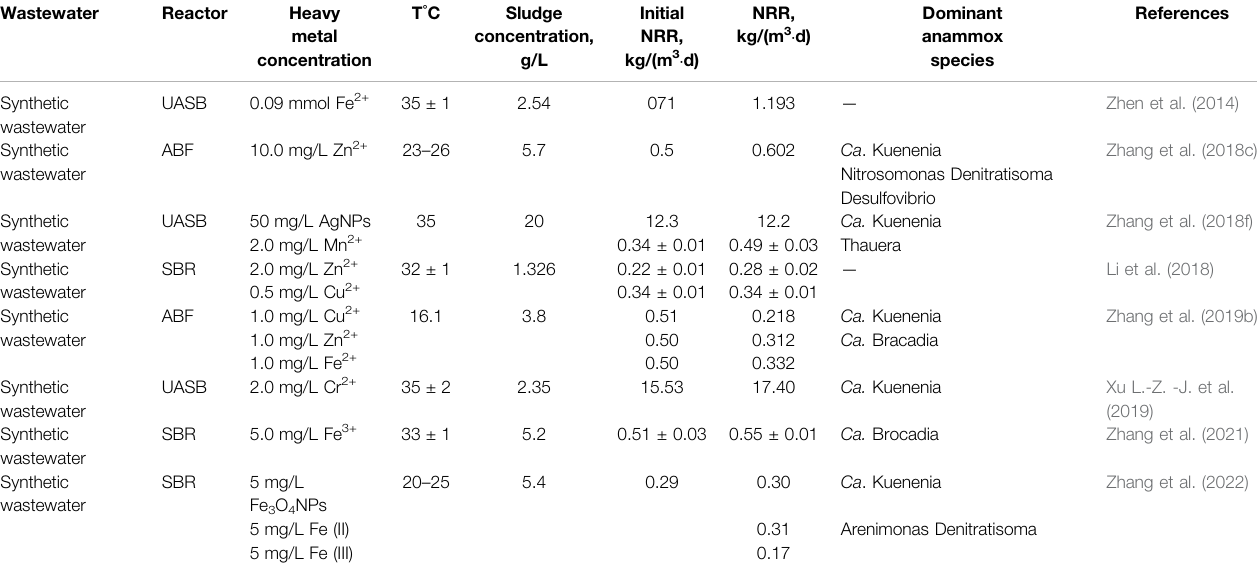
TABLE 1 | Nitrogen removal performance of anammox under the long-term exposure to heavy